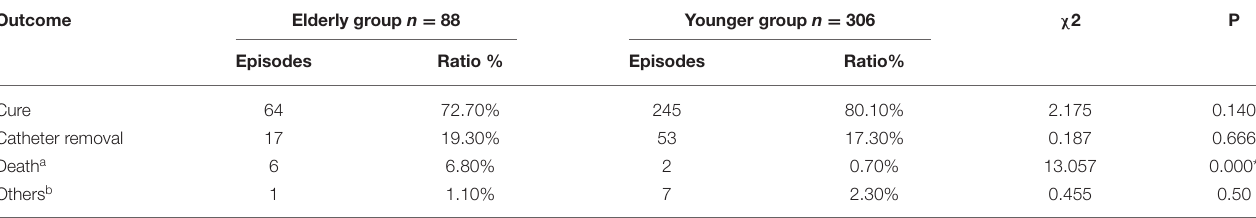
TABLE 4 | Outcomes of peritoneal dialysis-associated peritonitis in elderly and younger patients.